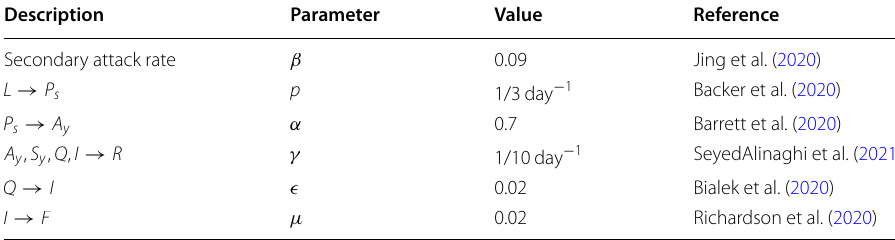
Table 1 Epidemiological parameters of simulation